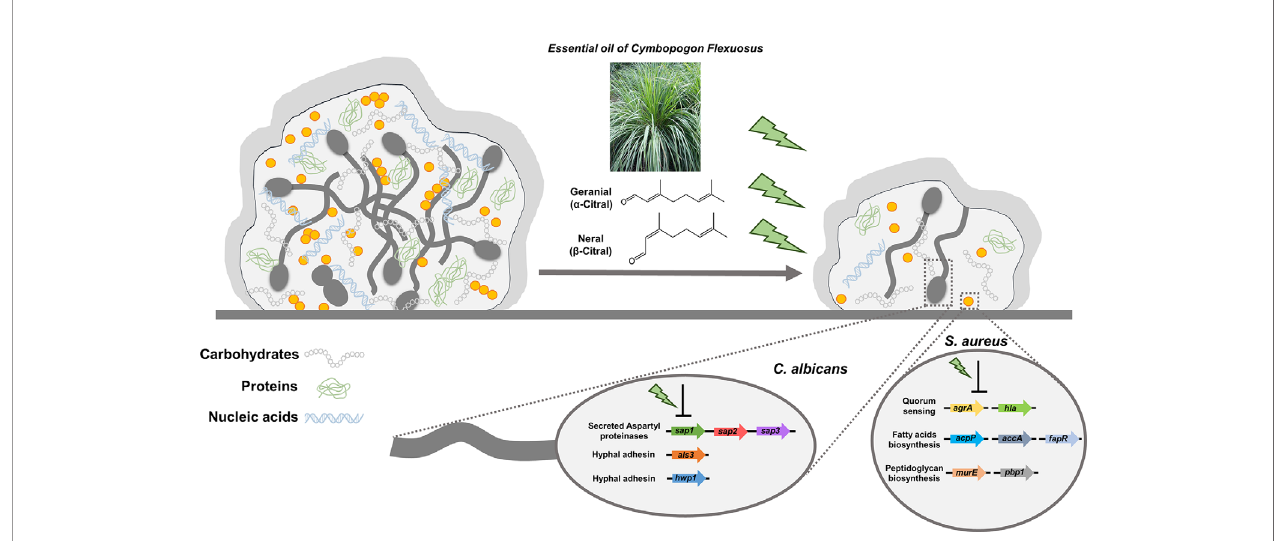
FIGURE 9 | Schematic diagram of lemongrass essential oil or citral targeting the matrix composition and molecular systems of C. albicans and S. aureus in dual- species bio fi lms. Lemongrass essential oil and citral breaks the adhesion of staphylococcal cells to the Candida hyphae, as well as breaking the major constitutes of bio fi lm matrix. These two agents also repress the transcriptional levels of adhesion factors, virulent and biosynthetic pathways in C. albicans and S. aureus inside the dual-species bio fi lms.